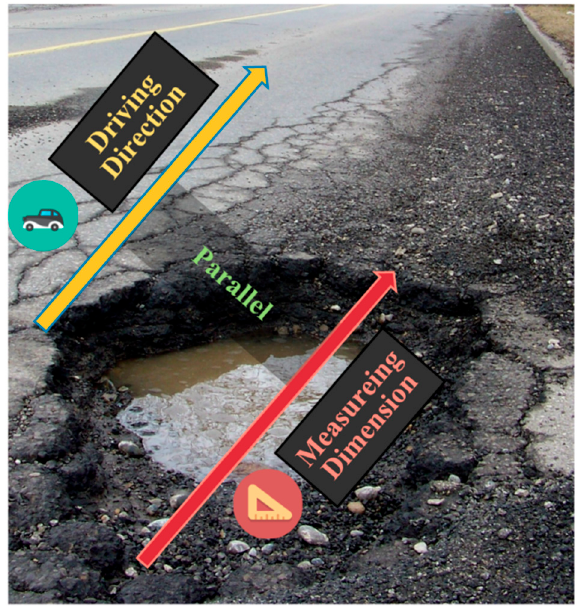
Figure 5. Illustration of the measuring dimension for road anomalies.